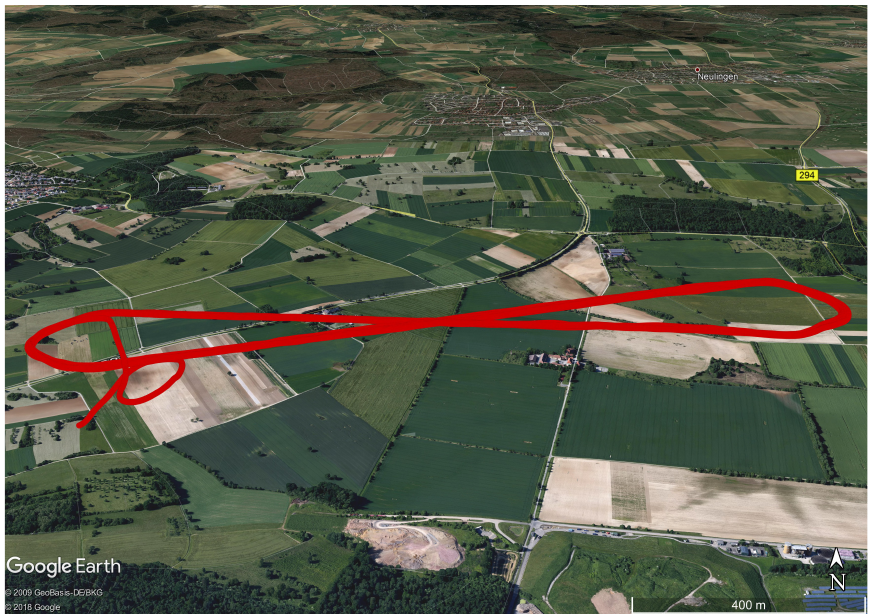
Figure 8. Flight path in red near Pforzheim (PFR) on 11 July 2013. During the measurement, low wind speed from northeast directions and pronounced convection